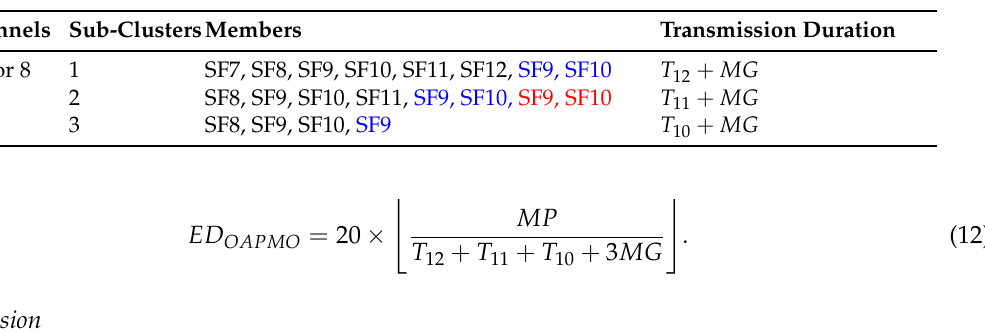
Table 3. Sub-cluster versus number of frequency channels for OAPM_O.